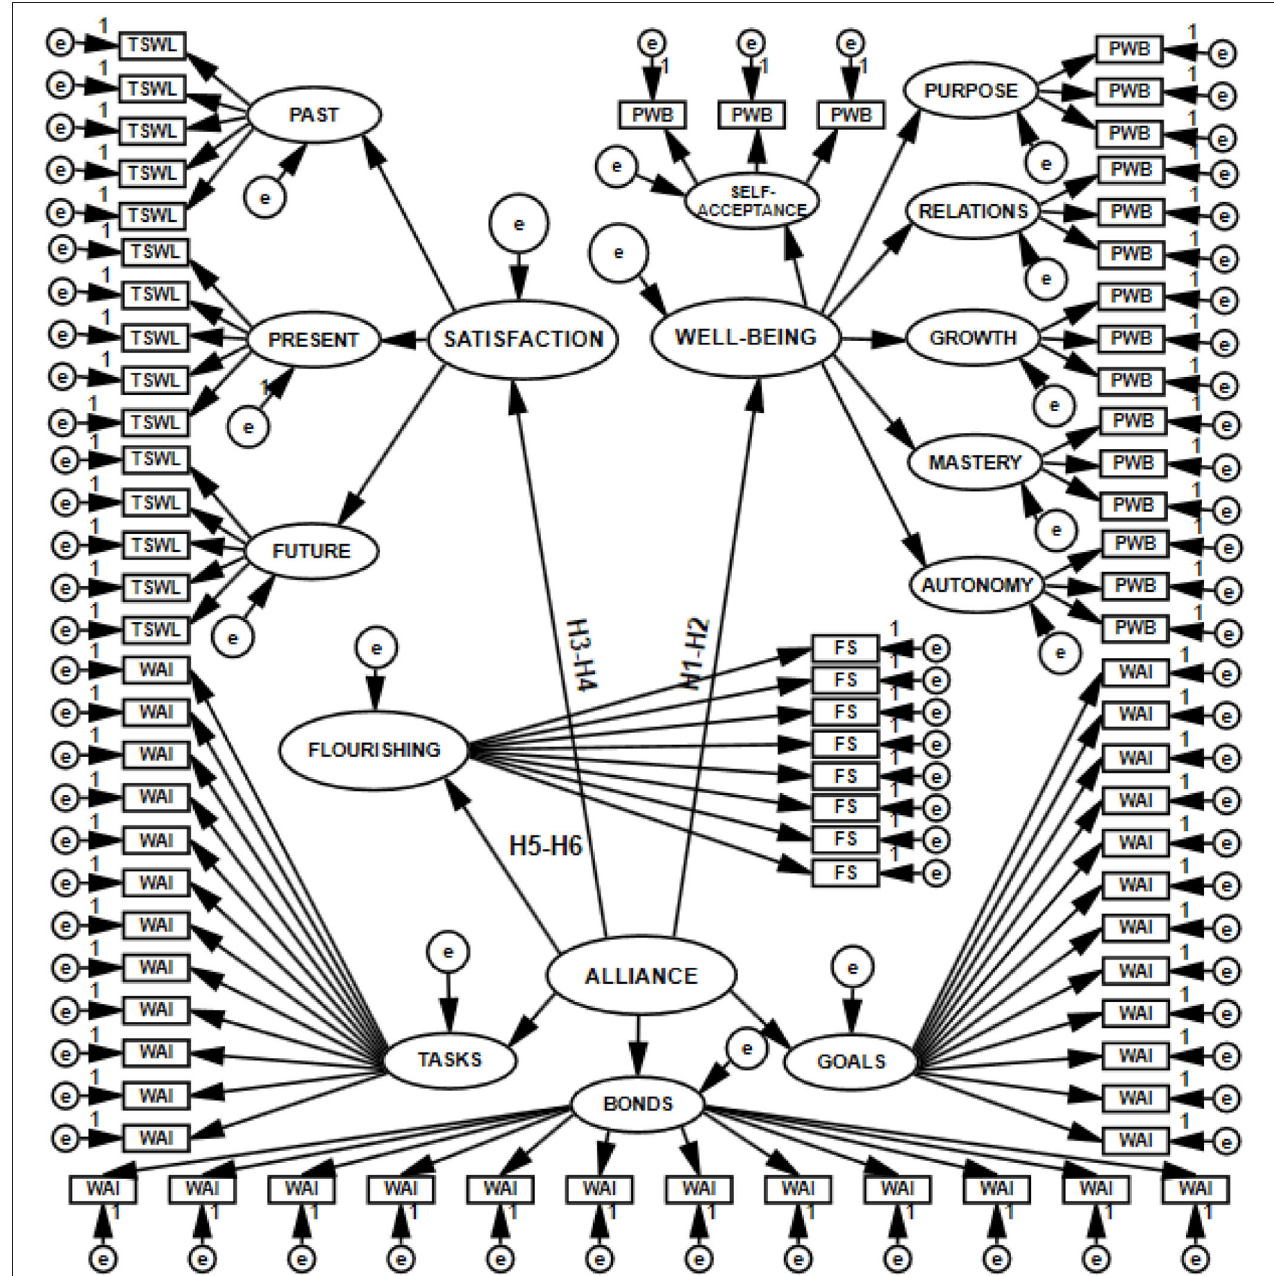
FIGURE 6 | Structural and measurement model with 16 latent variables postulating the direction of the relations of the working alliance to psychological well-being, life satisfaction, and flourishing, tested with SEM.